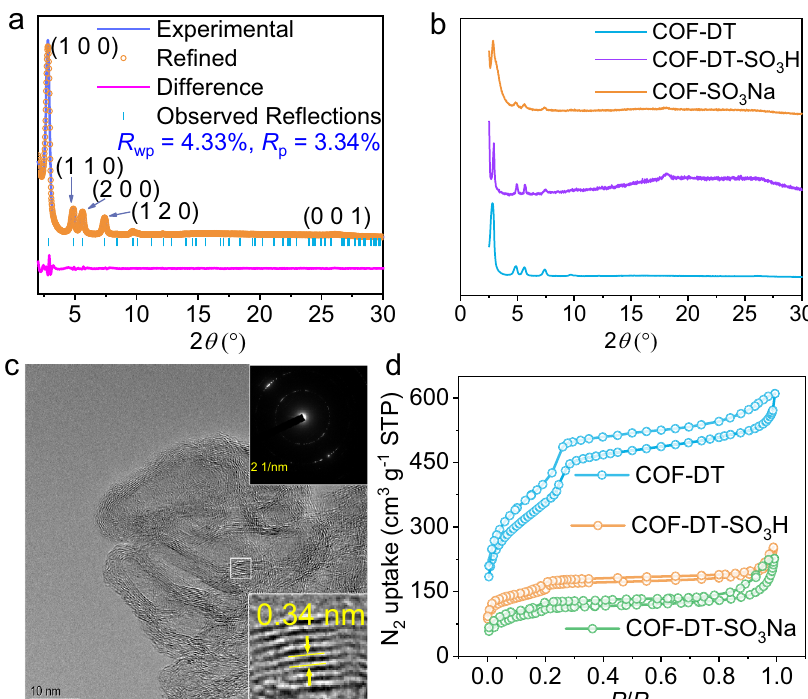
Fig. 3 Characterizations of COF-DT, COF-DT-SO 3 H, and COF-DT-SO 3 Na. a The experimental powder X-ray diffraction of COF-DT (blue line), the Pawley re fi ned plot (yellow circle), and the difference between experimental and re fi ned plot (purple line). b Comparison of experimental powder X-ray diffraction pattern of COF-DT (cyan line), COF-DT-SO 3 H (green line), and COF-DT-SO 3 Na (red line). c HR-TEM image of COF-DT. d Porous properties: N 2 sorption isotherm of COF-DT (cyan circle line), COF-DT-SO 3 H (orange circle line), and COF-DT-SO 3 Na (green circle